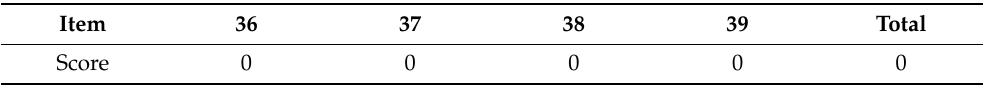
Table 8. Anna’s scores on the four items of the subcomponent, Procriminal Attitude/Orientation (PA).